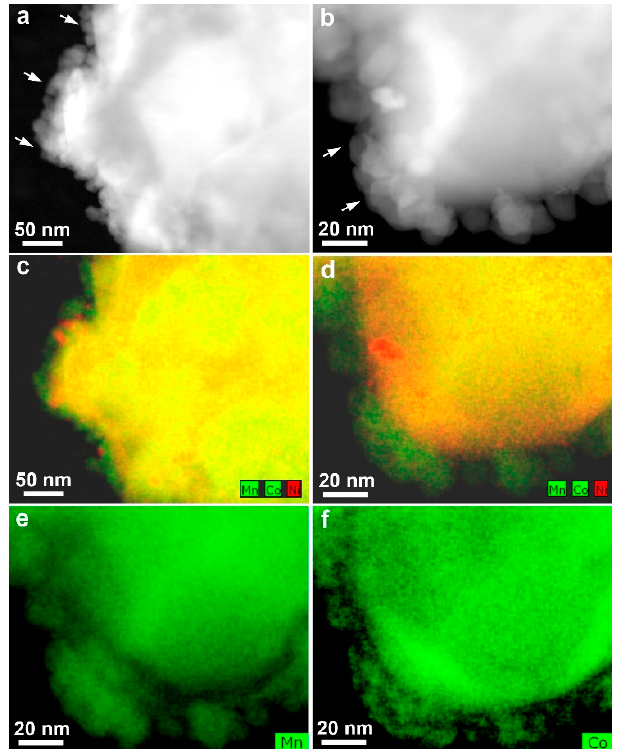
Figure 3. HAADF-STEM images ( a , b ) and compositional EDX maps ( c , d ) demonstrating the spinel nanocrystals covering crystallites of the Li 1.17 Ni 0.17 Mn 0.50 Co 0.17 O 2 phase in sample II annealed at 400 °C using low precursor concentration. The spinel phase is seen as green nanocrystals at the surface as it does not contain Ni ( e , f ). Few Ni-rich areas (red) are attributed to local inhomogeneity in the Li-rich NMC crystals.